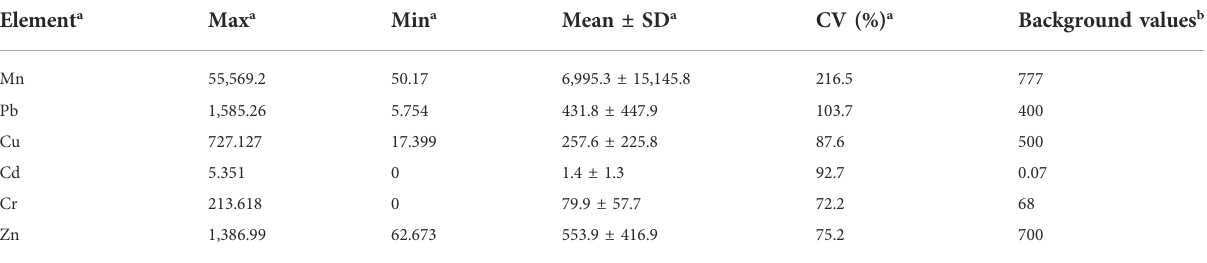
TABLE 3 Heavy metal concentrations and fundamental characteristics in soils sampled in this study (mg/kg): Descriptive statistics. Element a